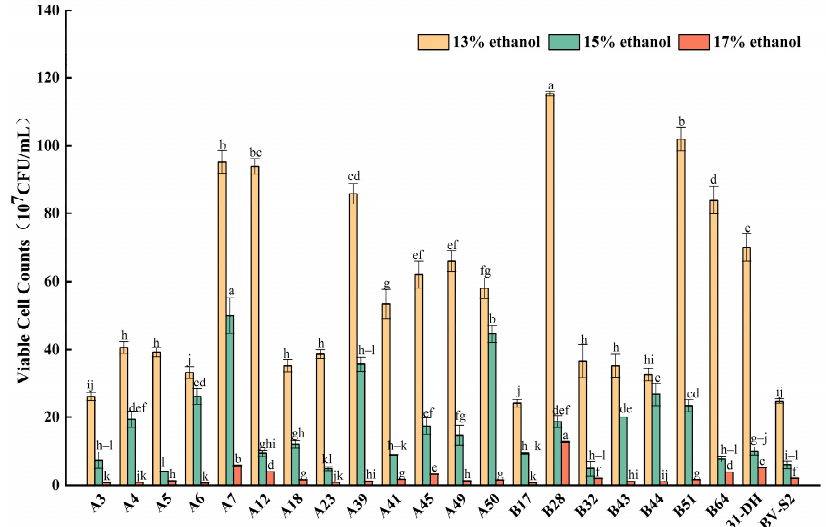
Figure 2. Growth of twenty L. plantarum and control strains in MRS-AJ, which contained 13, 15, and 17% ( v / v ) ethanol, respectively. Different small letters indicate significant differences according to the LSD Fisher test ( p <